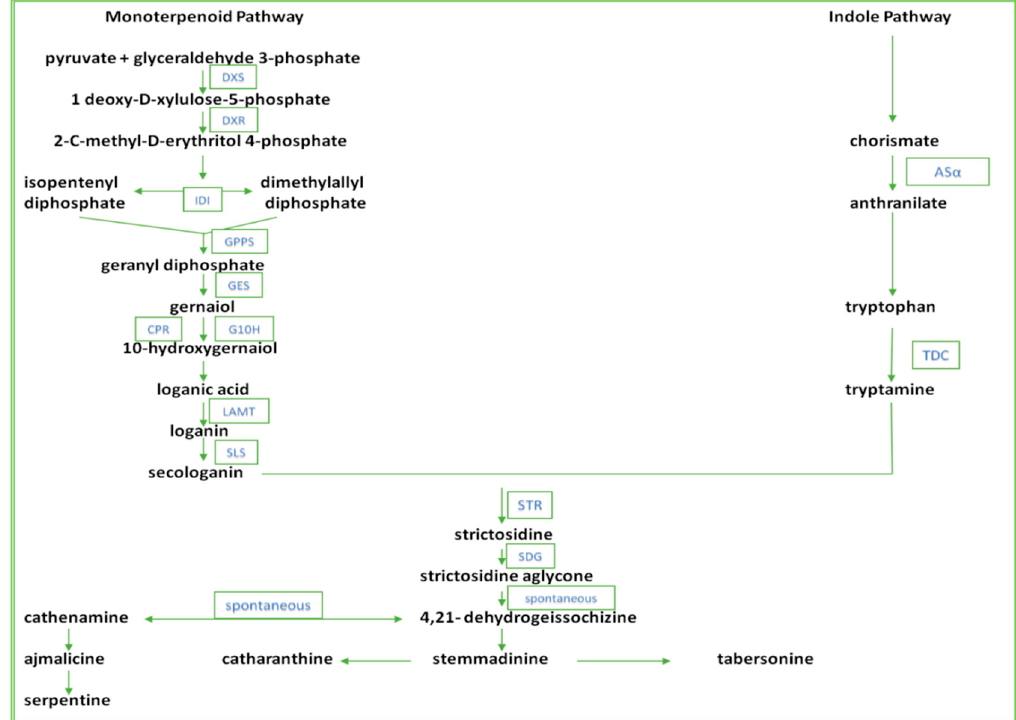
Figure 5. Overview of the biosynthesis of ajmalicine in C. roseus . (AS, anthranilate synthase; CPR, cytochrome P450 reductase; DXR, 1-deoxy-D-xylulose-5-phosphate reductoisomerase; DXS, 1-deoxy-D-xylulose-5-phosphate synthase; G10H, geraniol 10-hydroxylase; GES, geraniol synthase; GPPS, geranyl diphosphate synthase; IDI, isopentenyl diphosphate isomerase; LAMT, loganic acid O -methyltransferase; SDG, strictosidine glucosidase; SLS, secologanin synthase; STR, strictosidine synthase; TDC, tryptophan decarboxylase).